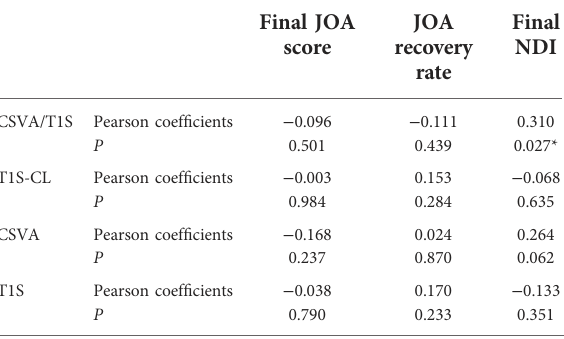
TABLE 5 Correlations between T1S, CSVA, T1S-CL, CSVA/T1S, fi nal JOA score, JOA recovery rate, fi nal